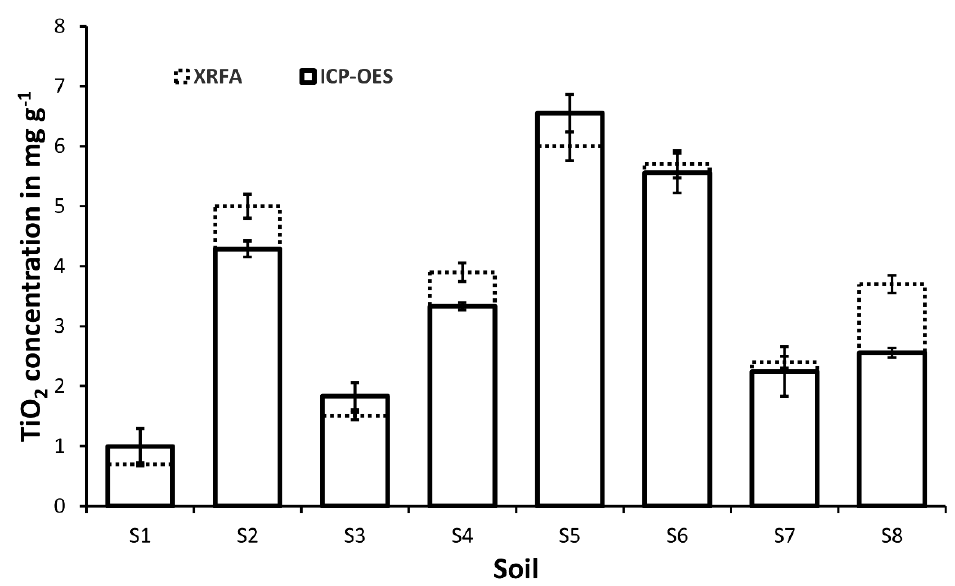
Figure 2. Concentration of TiO 2 in the investigated soils determined using XRFA (total content, dashed lines) and ICP-OES after piranha acid digestion and centrifugation (soluble fraction, full lines). The length of the error bars corresponds to two times the standard deviation determined for three sample replicates.